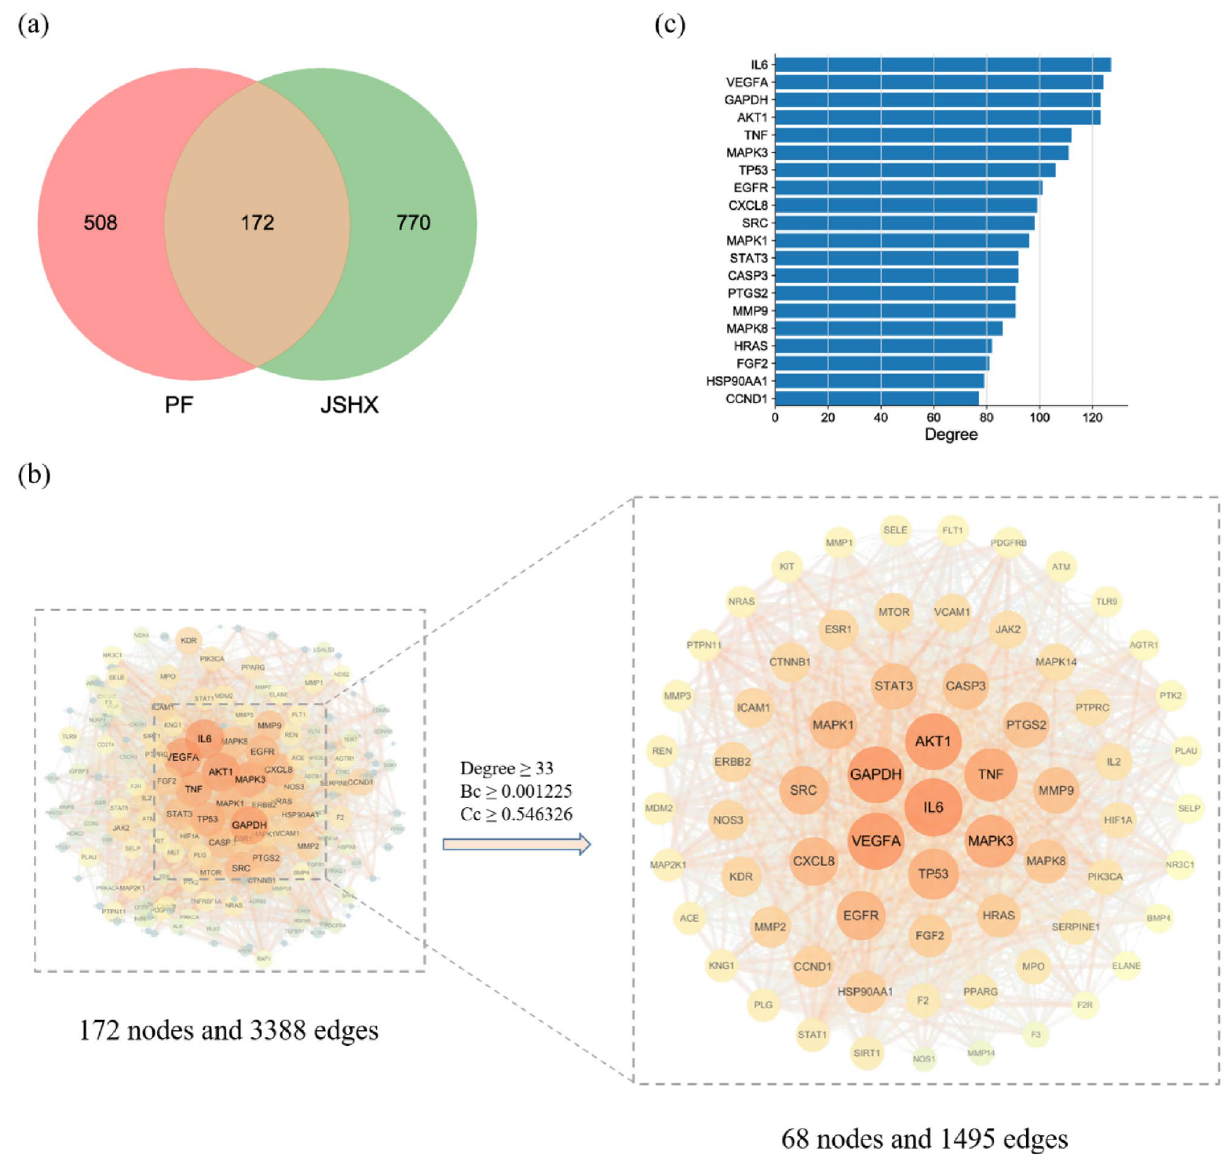
Figure 7. ( a ) Intersection of Venn diagram. ( b ) The process of topological screening for the protein–protein interaction network. ( c ) Node degree value. The horizontal axis represents the degree value of nodes; the vertical axis represents